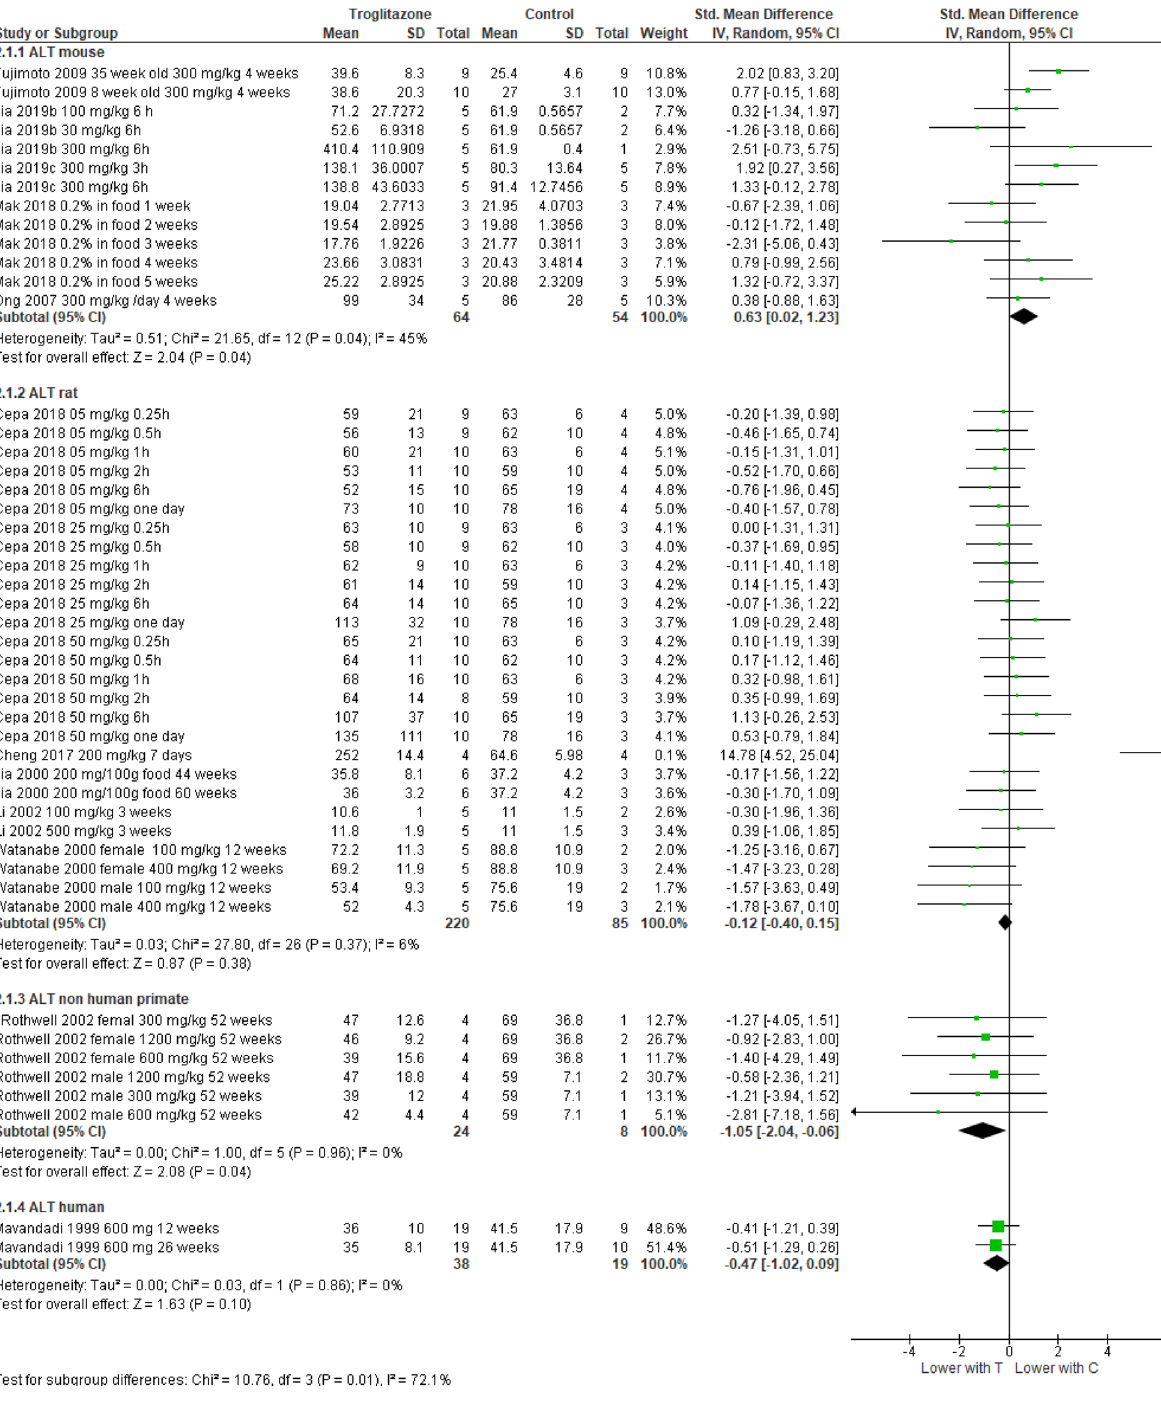
Figure 3. Forest plots are presented separately for troglitazone and for rosiglitazone. Each outcome is sorted by species, increasing dose of the drug and increasing follow-up